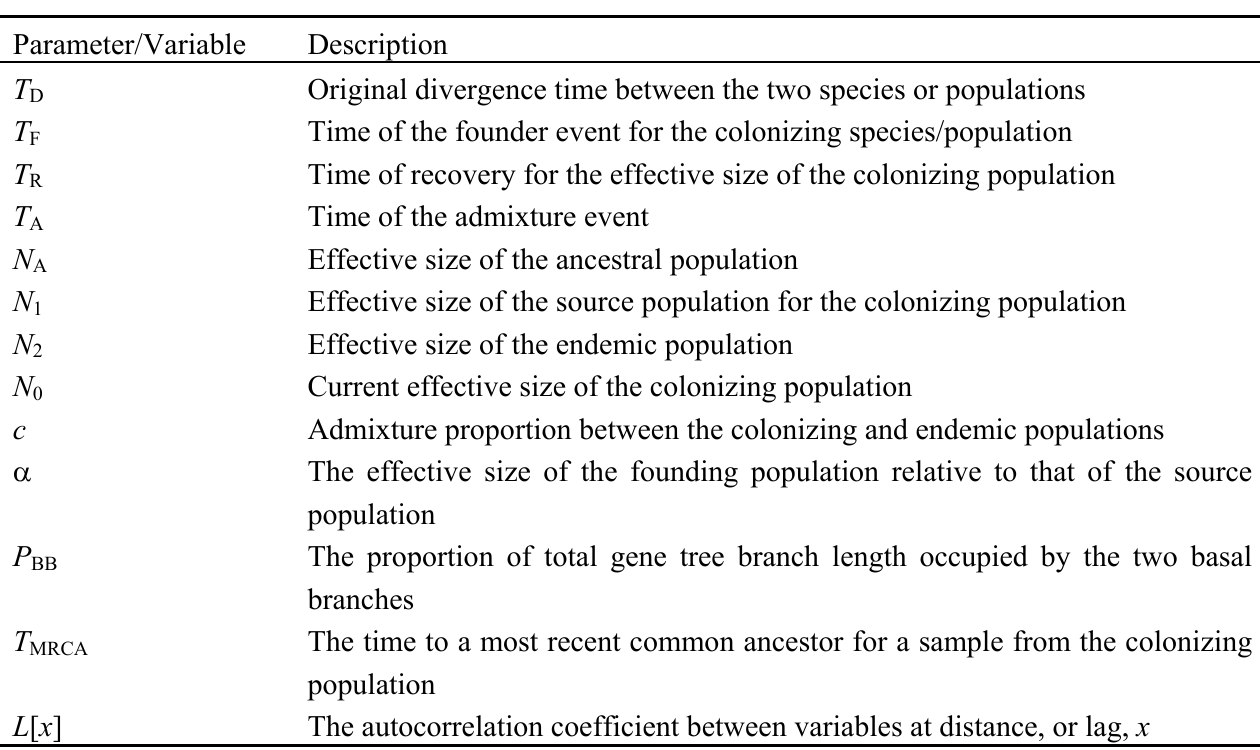
Table 1. Description of the parameters of the ten parameters of the Isolation-and- Admixture (IAA) model and the two variables used to measure the properties of genetic variation expected under the